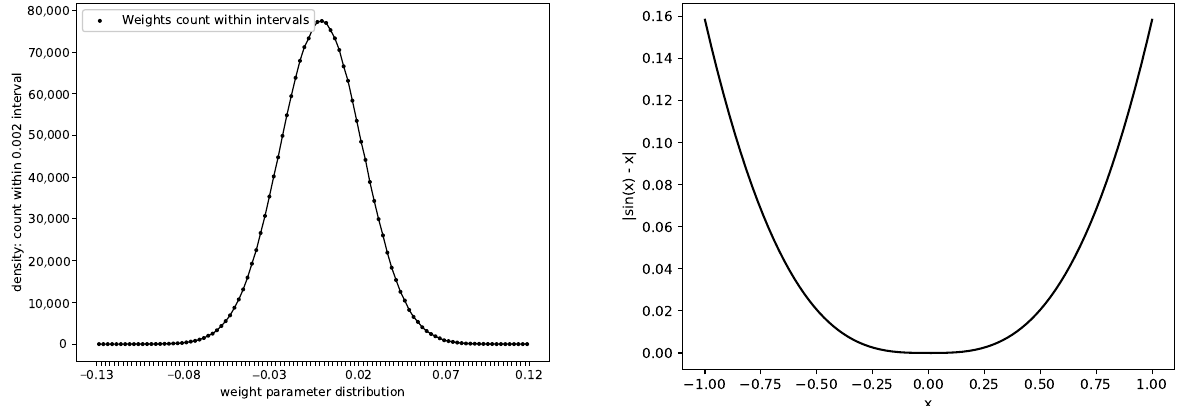
Figure 2. Weight distribution and approximation error curve. The left subfigure shows the distribution of weight parameters extracted from a random layer of a 28-layer WideResNet trained on the CIFAR-100 dataset. The right subfigure is drawn from | sin ( x ) − x | , which denotes the approximation